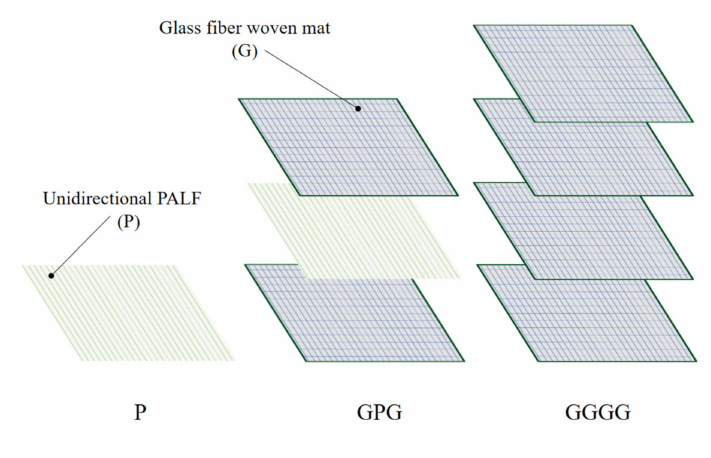
Figure 1. Schematic of fiber composition